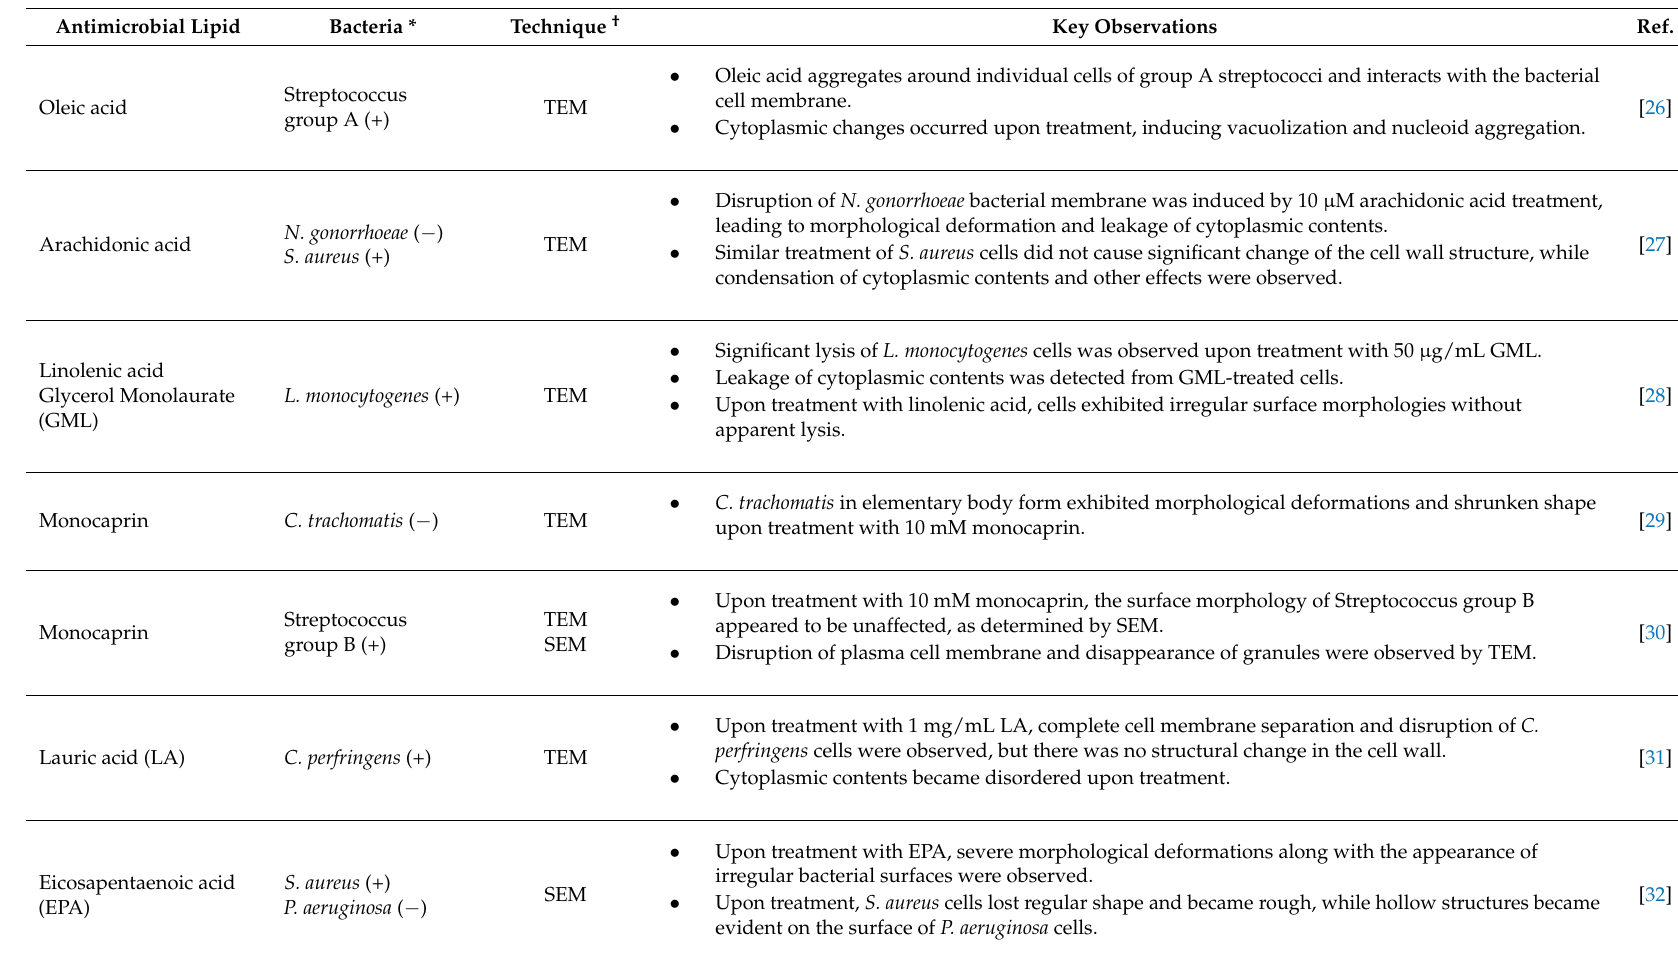
Table 5. Electron microscopy studies reporting how antibacterial fatty acids and monoglycerides affect bacterial cells. Antimicrobial Lipid Key Observations